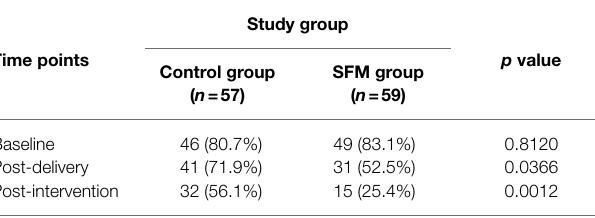
TABLE 3 | Comparison of frequency distribution of postpartum depression between the two groups at different time points.